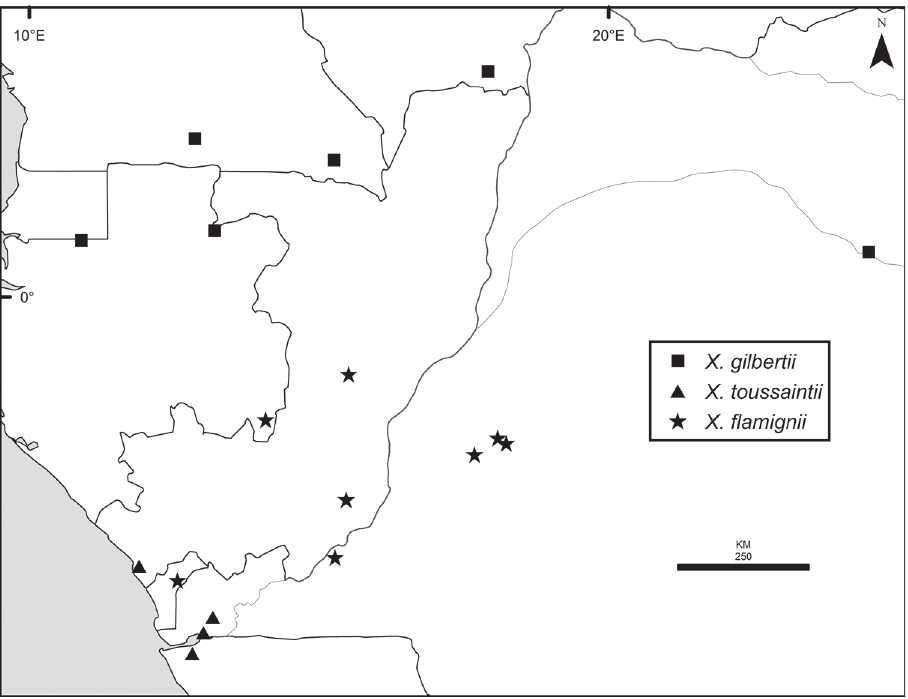
Figure 24. Distributions of Xylopia gilbertii , X. toussaintii , and X. flamignii . Bolder lines represent country borders, fainter lines lakes and major